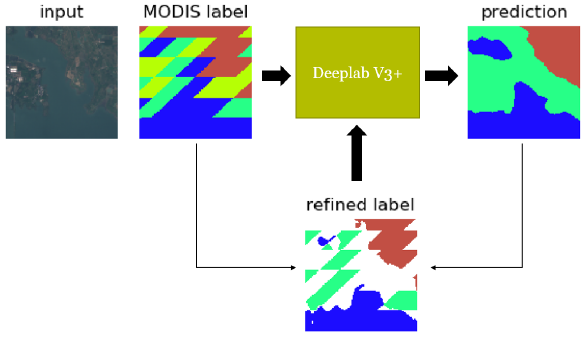
Figure 3: Label refinement process (Ignore mask is in white)